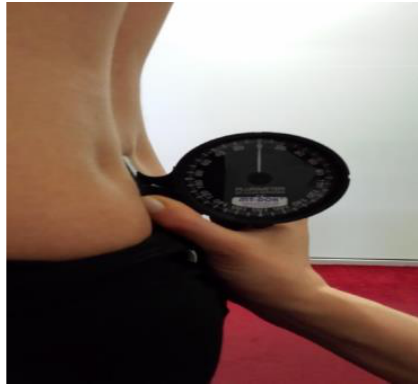
Table 2. Significant gender differences in the analysed characteristics of body build and posture between women and men in